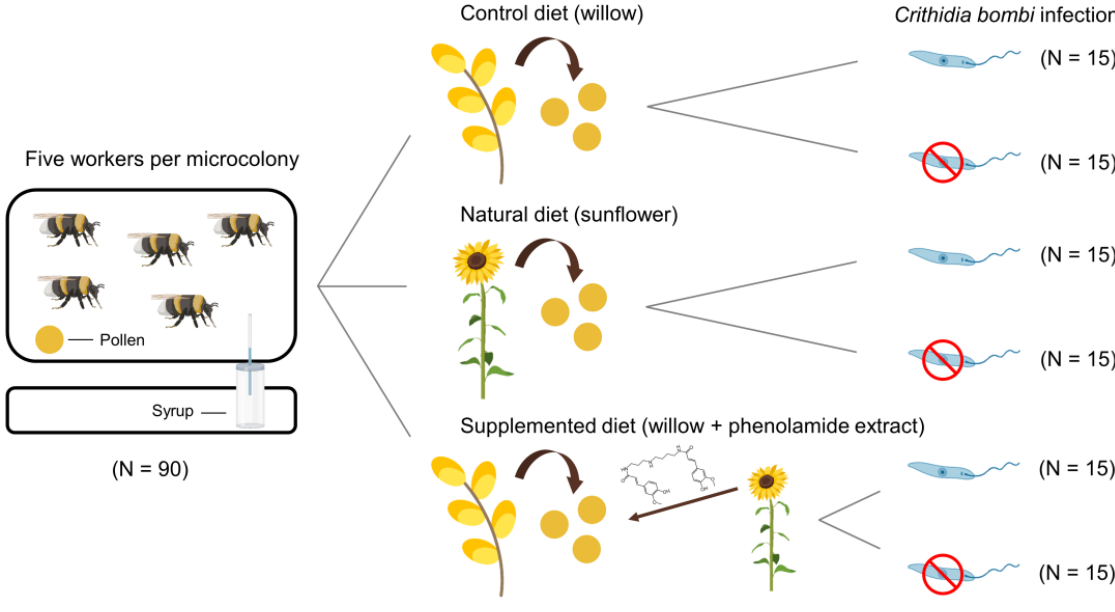
Figure 1. Experimental design and summary of the six treatments provided to Bombus terrestris microcolonies. Each microcolony consisted of five workers that were fed for 35 days. Phenolamide structure: N,N ’ -diferuloyl spermidine. This figure was created using BioRender (https://app.biorender.com/ accessed on 22 January 2022) and Flaticon (https://www.flaticon.com/ accessed on 22 January 2022).